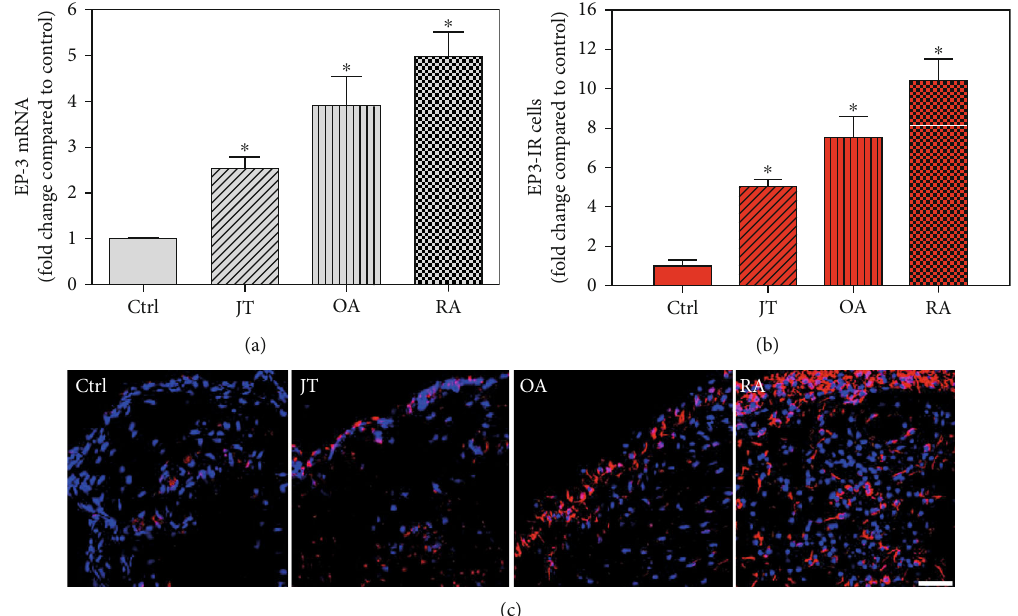
Figure 6: Detection of PGE-2 receptor 3 (EP3 receptor) mRNA (a) and number of EP3-IR cells (b, c) in patients with joint trauma (JT), osteoarthritis (OA), and rheumatoid arthritis (RA). (a) Quanti fi cation of EP3 mRNA shows that EP3 mRNA was signi fi cantly higher in JT, OA, and RA compared to control synovium (data are shown as means ± SEM , P < 0 : 05 , one-way ANOVA followed by Tukey ’ s test) but was more prominent in OA and RA. (b) Quantitative analysis of immuno fl uorescence microscopy for EP3-IR cells relative to the control synovium (data are shown as means ± SEM , P < 0 : 05 , Kruskal – Wallis ANOVA on ranks followed by Dunn ’ s test). (c) Immuno fl uorescence microscopy shows more abundant EP3-IR cells (Texas red fl uorescence) in RA and OA compared to JT and control synovium. DAPI blue fl uorescence shows nuclear staining. Bar = 20 μ m . ( ∗ P < 0 : 05 , compared to